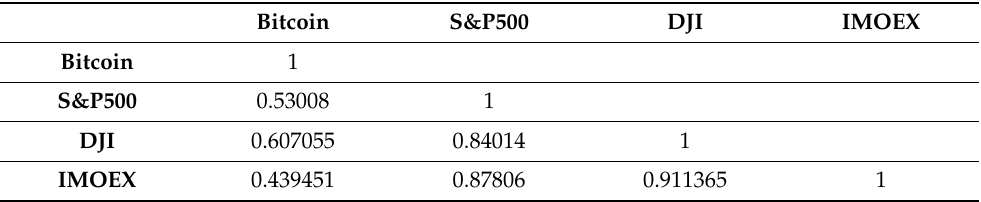
Table 3. Correlation analysis of daily returns.